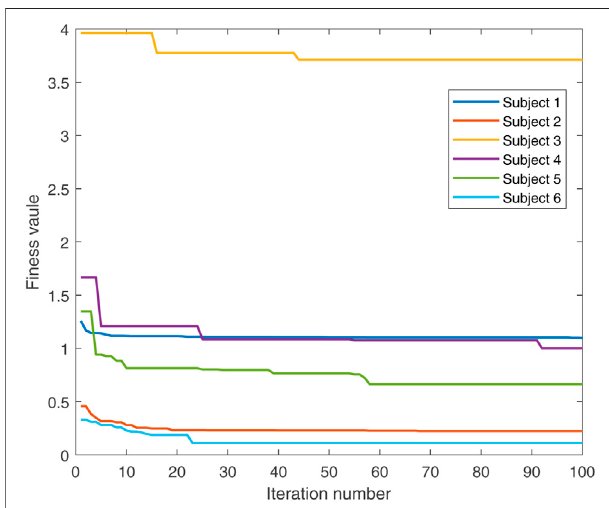
FIGURE 10 | Upper fi tness value curves searched by the proposed method for the six